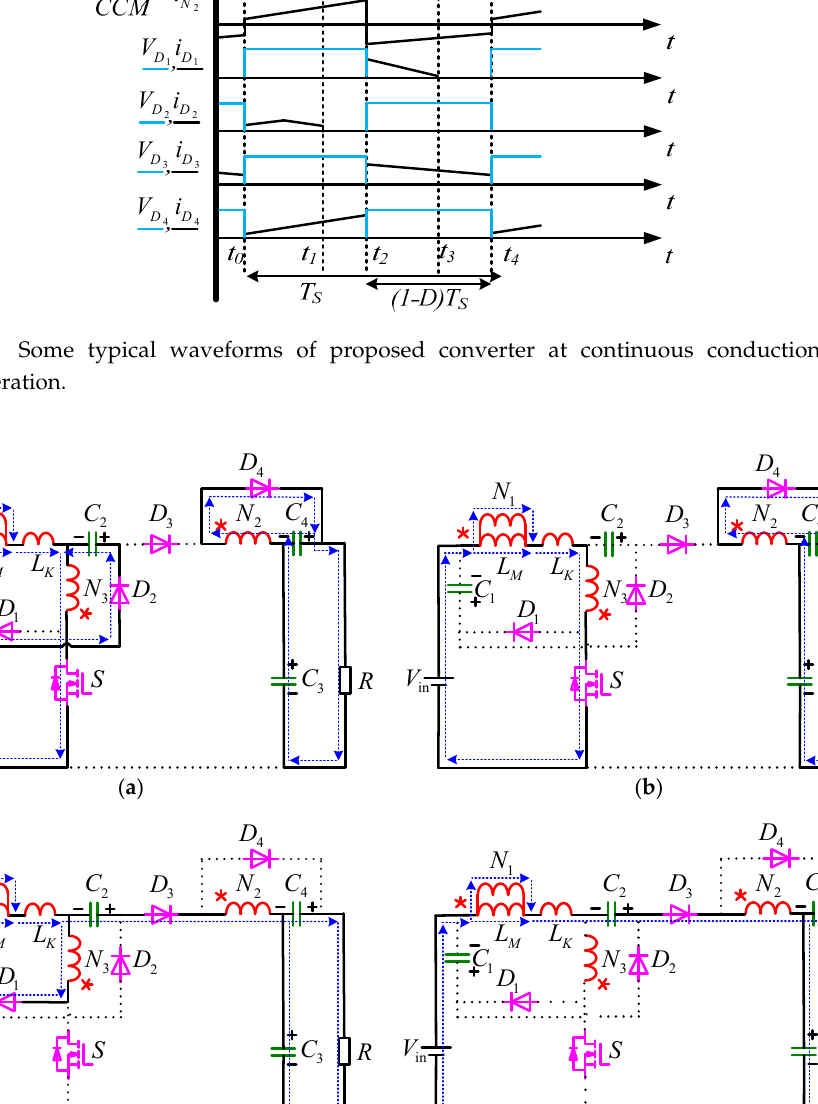
Figure 2. Some typical waveforms of proposed converter at continuous conduction mode (CCM) operation.